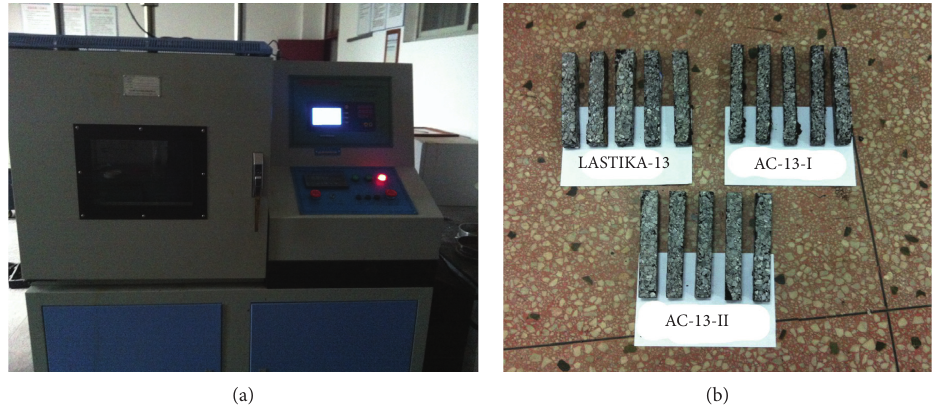
Figure 6: (a) Testing equipment and (b) beam samples.